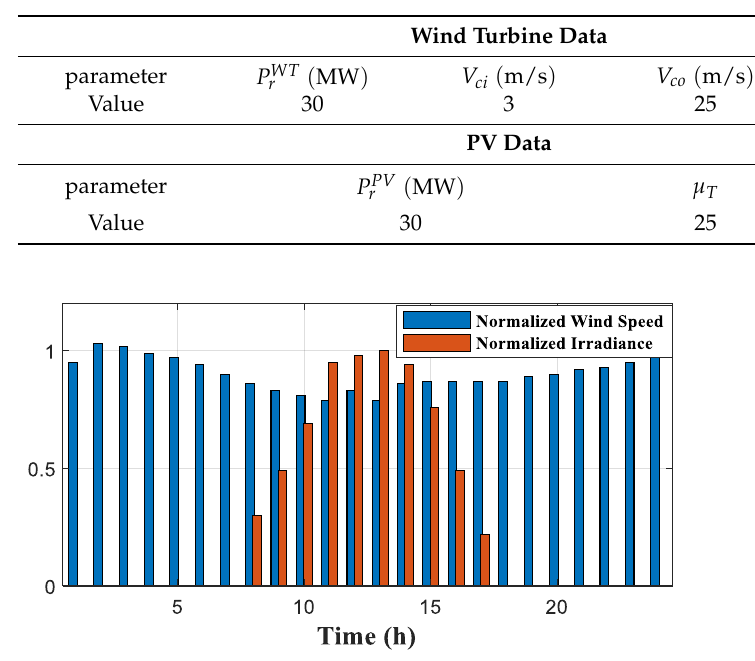
Figure 17. Normalized wind speed and normalized irradiance over all intervals.